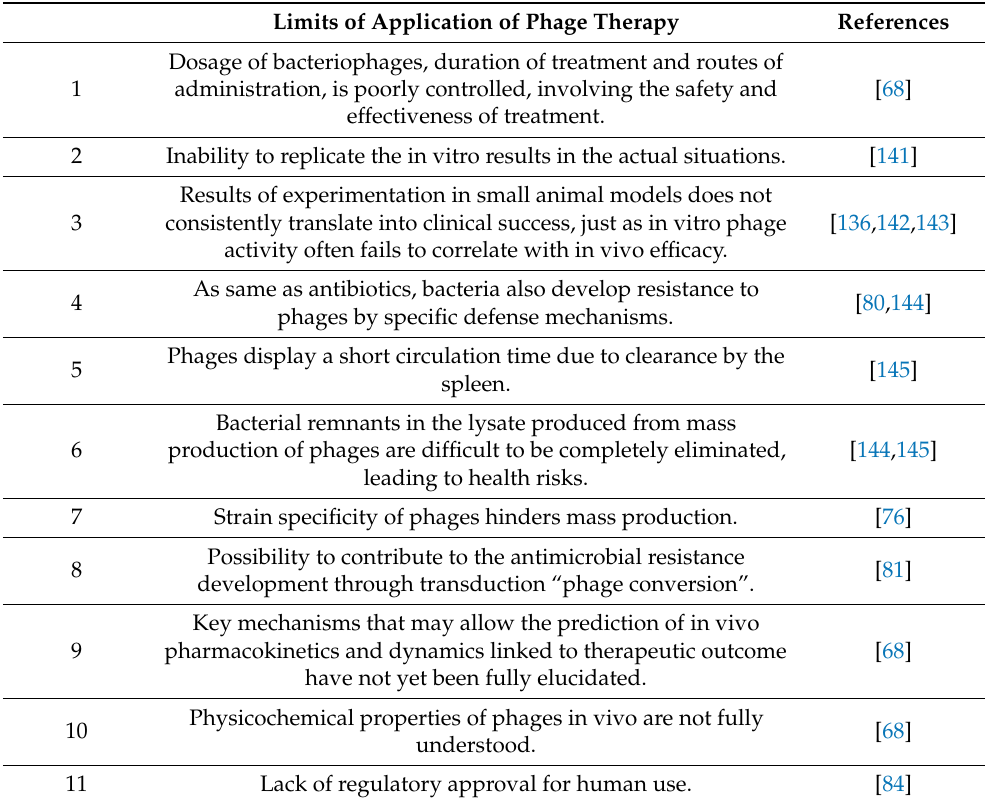
Table 3. Limits of application of phage therapy in modern human medicine. Limits of Application of Phage